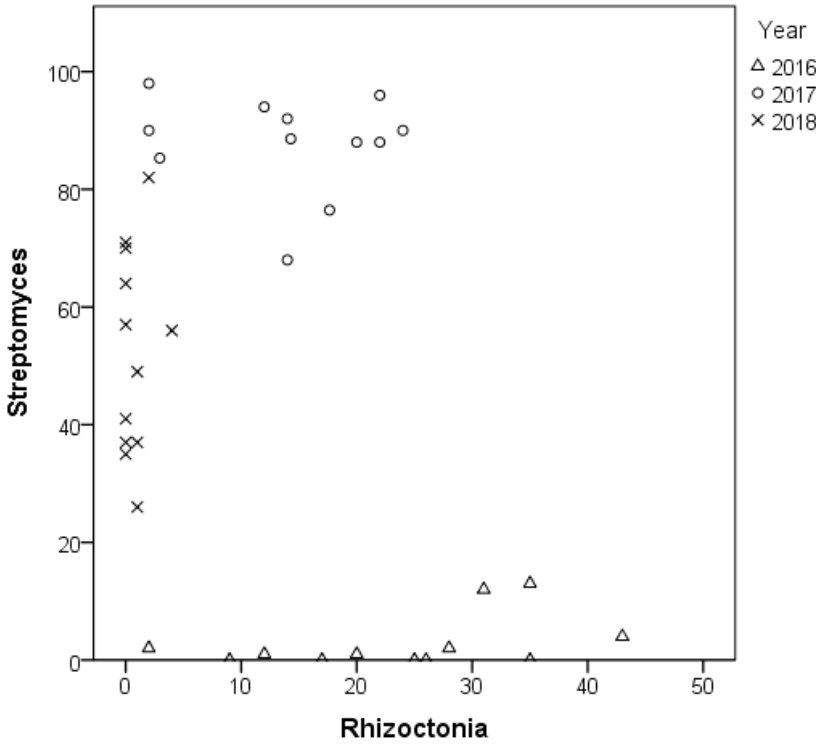
Figure 8. Correlation regression analysis between Rhizoctonia sp. and Streptomyces sp. infection incidence, assessed in three consecutive years ( n = 12 in each year).